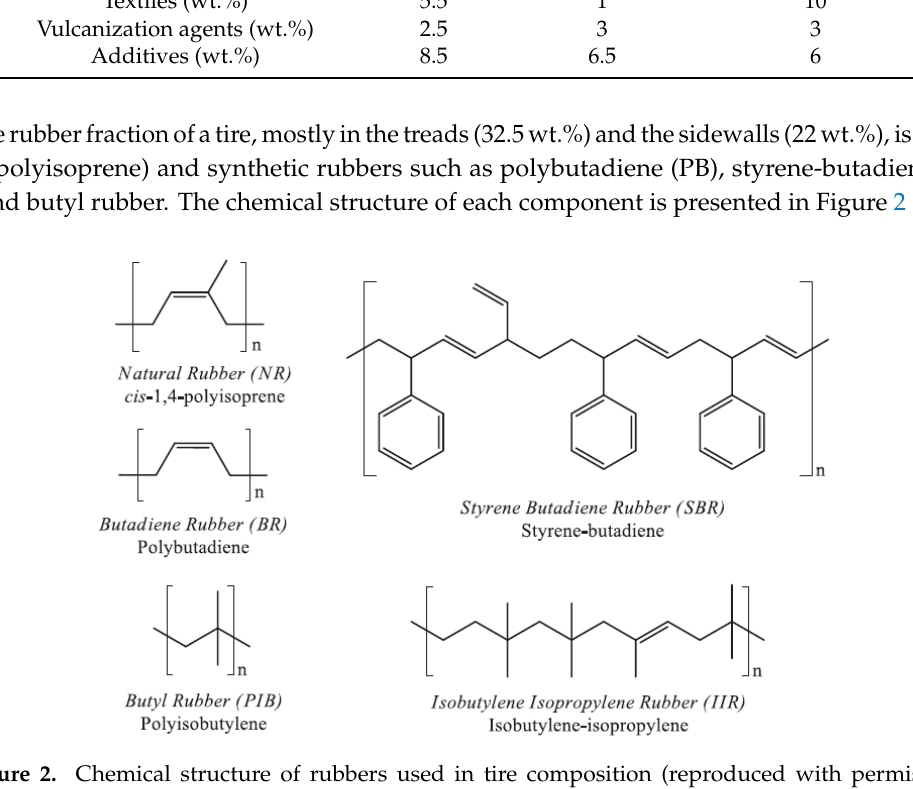
Table 1. Tire composition depending on the application (reproduced with permission from [28]). Material Car tire Truck tire Off-the-road tire Rubbers/Elastomers (wt.%) Carbon black and silica (wt.%)